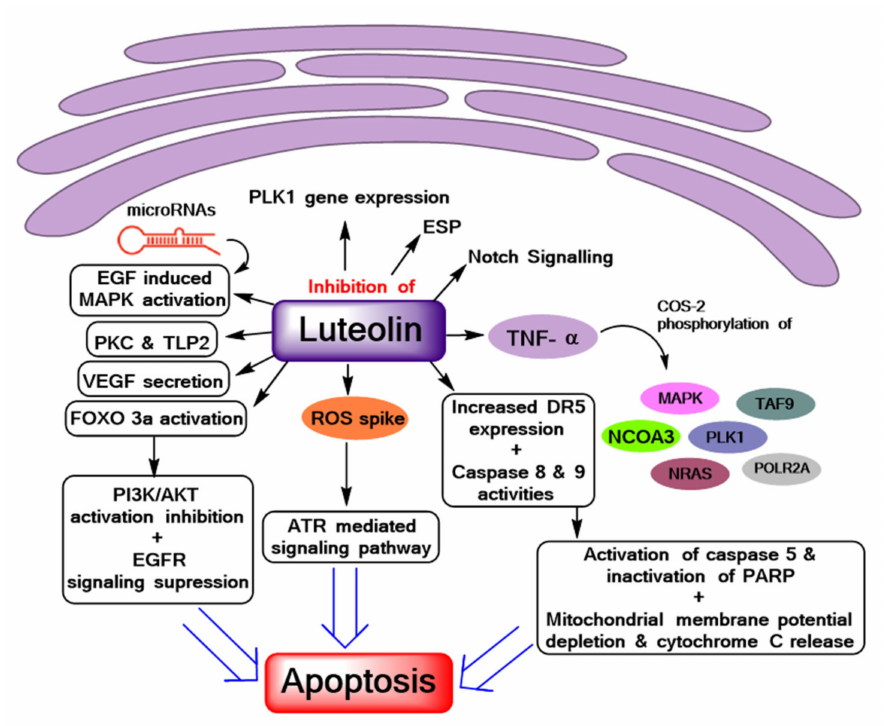
Figure 1. Reported mechanistic bases of luteolin anti-cancer activity. PARP: poly ADP-ribose polymerase; EGFR: endothelial growth factor receptor; ROS: reactive oxygen species; DR5: death receptor 5; PLK1: polo-like kinase 1; PI3K: phosphatidylinositol 3-kinase; MAPK: mitogen-activated protein